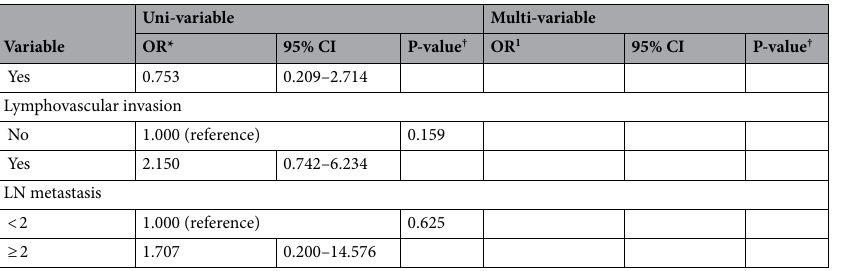
Table 4. Uni- and multi-variable logistic regression analysis for risk factors in early and systemic recurrence. ASA classification American Society of Anesthesiologists physical status classification, CA 19-9 Carbohydrate